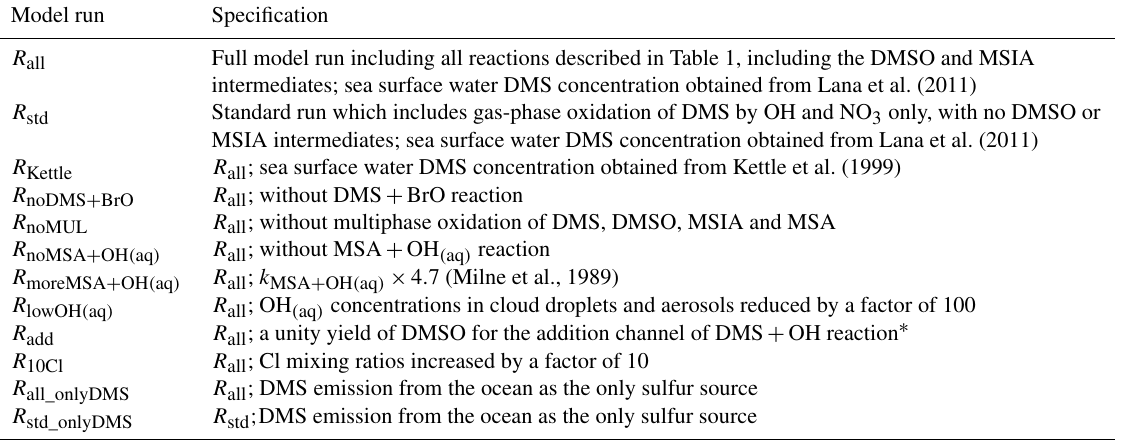
Table 3. Overview of model runs. Model run